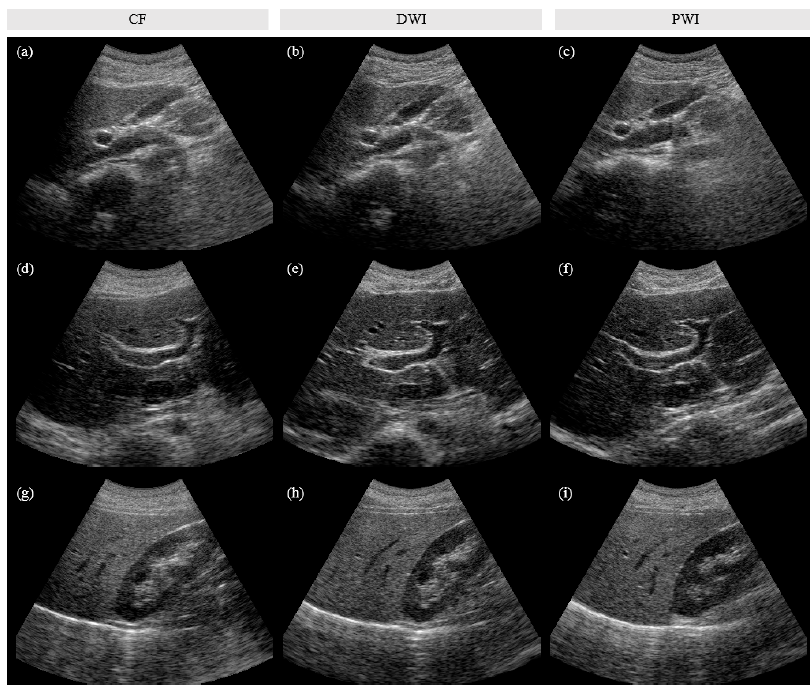
Figure 5. Representative in vivo images of ( a – c ) gallbladder, ( d – f ) liver, and ( g – i ) kidney, which were reconstructed by using CF (for ( a , d , g )), DWI (for ( b , e , h )), and PWI (for ( c , f , i )). PWI showed better image quality with a 4-fold higher acquisition frame rate than CF and provided a comparable performance with a 2.9 times lower number of computations compared to